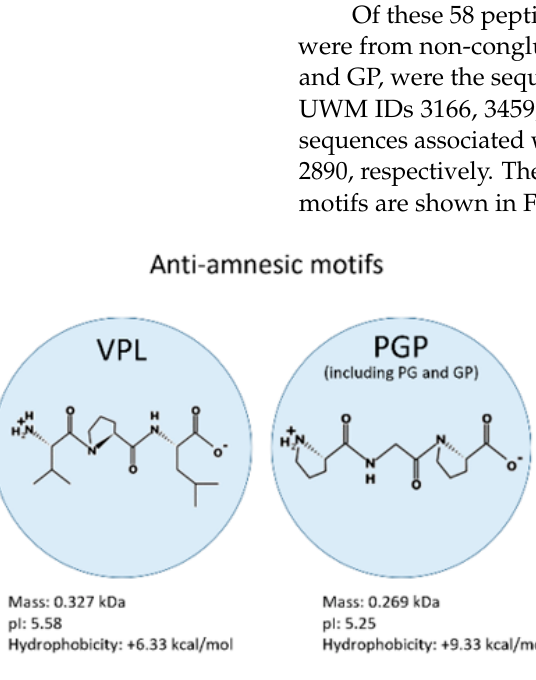
Figure 2. Physicochemical properties and primary structures of the anti-amnesic and anxiolytic motifs. pI, isoelectric point.